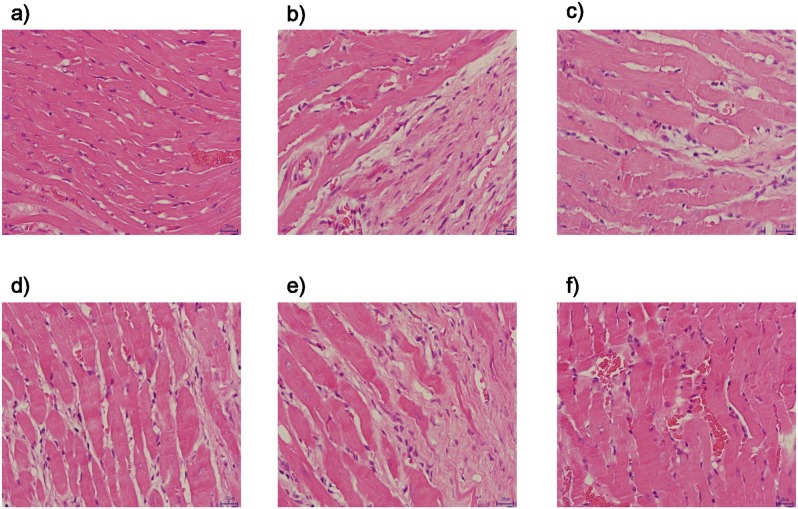
Effects of QSYQ on HE results after occlusion of the left anterior descending (LAD) artery in rats.Cardiomyocytes in the sham group were orderly arranged, and the nuclei were lightly stained and located in the center of muscle fibers. Thickening and lengthening of myocardial fibers could be observed in model group, wherein the nuclei were darkly stained. Cardiomyocyte hypertrophy, cellular degeneration and inflammatory cell infiltration were significantly improved in the different dosage of QSYQ group and Captopril group by contrast with those in the model group. a). cardiomyocytes in sham group; b). cardiomyocytes in model group; c) cardiomyocytes in QSYQ (H); d) cardiomyocytes in QSYQ (M); e) cardiomyocytes in QSYQ (L); f) cardiomyocytes in Captopril group.